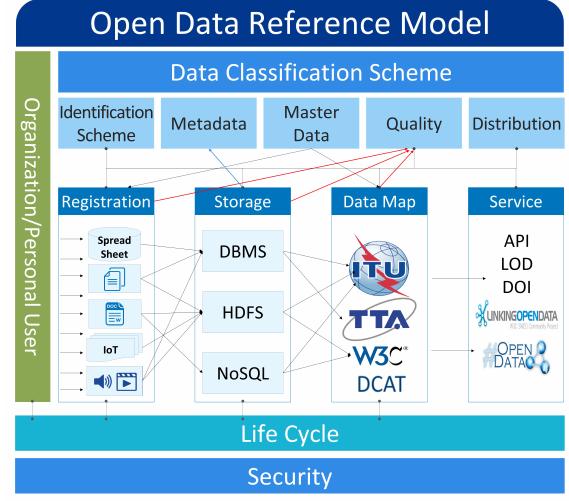
Figure 7. Main operations of Open Data Reference